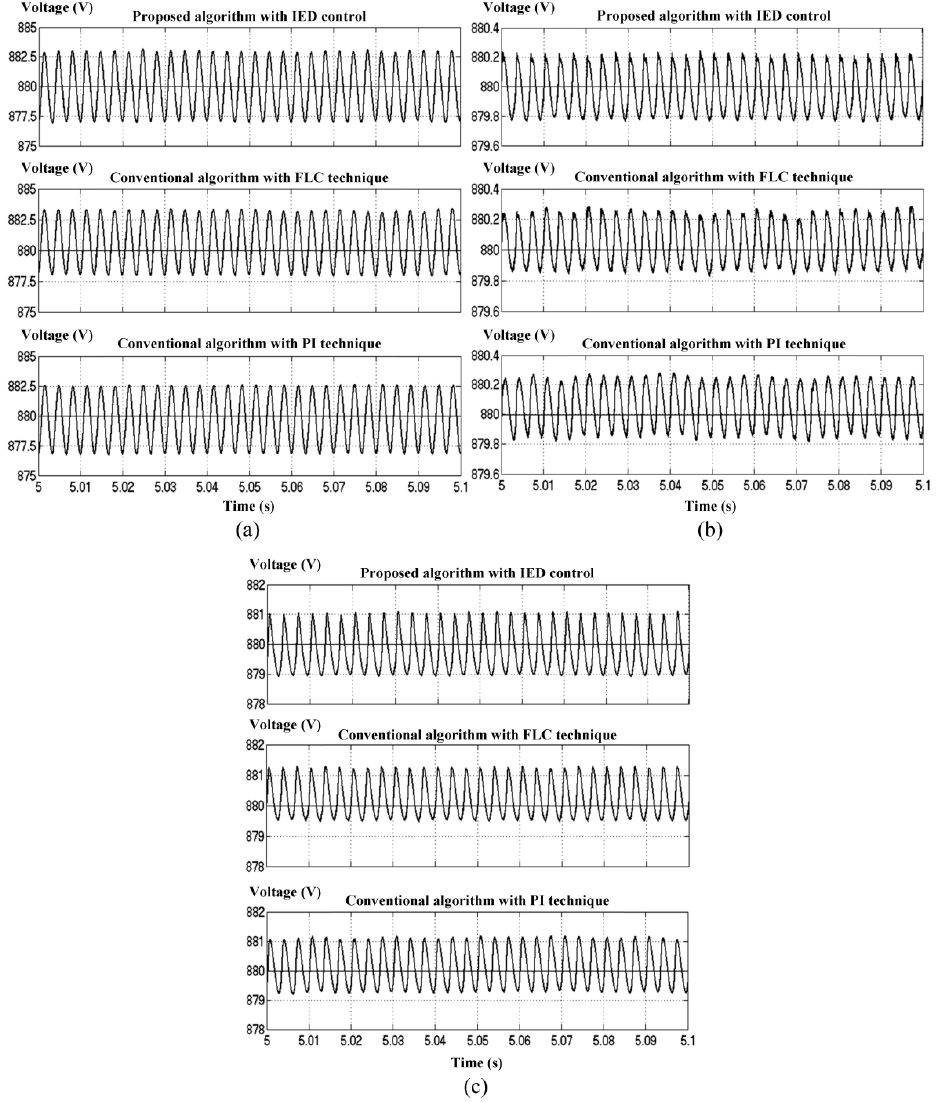
Figure 7. Performance comparison of DC-link capacitor voltage regulation algorithms with reference voltage of 880 V for steady-state conditions of ( a ) capacitive; ( b ) inductive and ( c ) resistive loads.